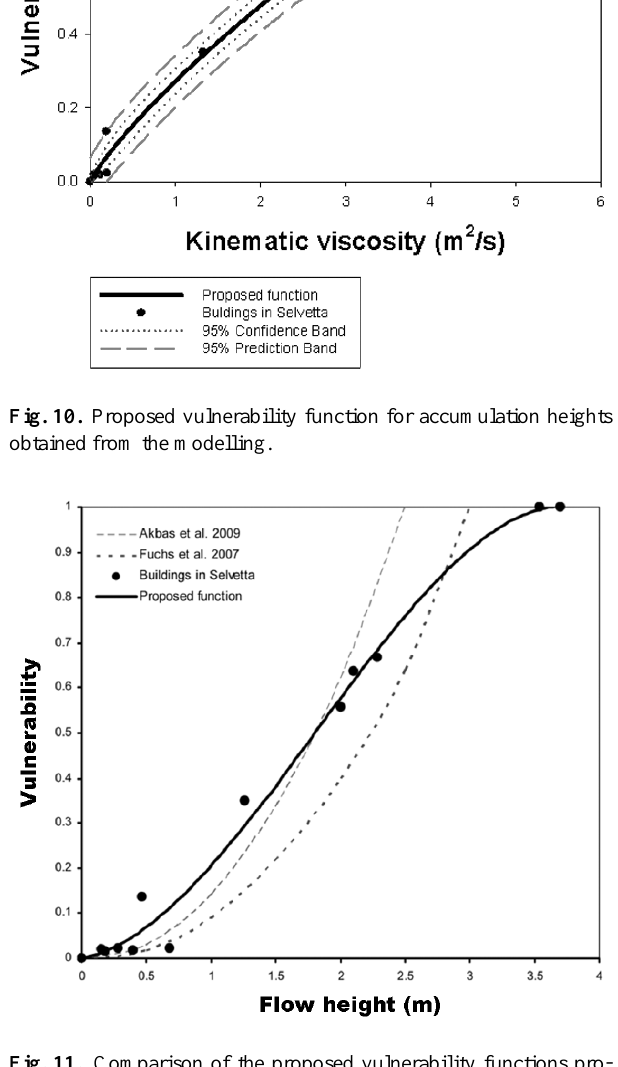
Fig. 9. Proposed vulnerability function for modelled impact pres- sures.